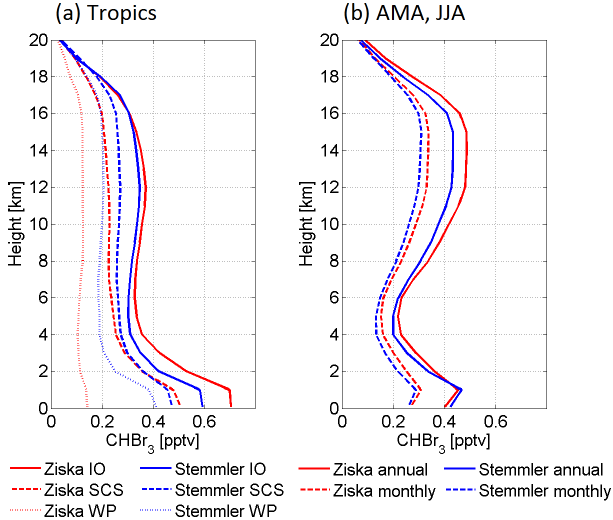
Figure 3. (a) Annual mean tropical (20 ◦ S–20 ◦ N) VMR profiles of bromoform over the Indian Ocean (IO: 40–90 ◦ E), the South China Sea (SCS: 90–130 ◦ E), and the west Pacific (WP: 130–160 ◦ E) from the Ziska Updated and Stemmler Scaled inventories with monthly averaged emissions. (b) Bromoform VMR profiles in the Asian monsoon anticyclone region (AMA: 10–40 ◦ N, 20–90 ◦ E) in JJA from both inventories with monthly and annually averaged emis-